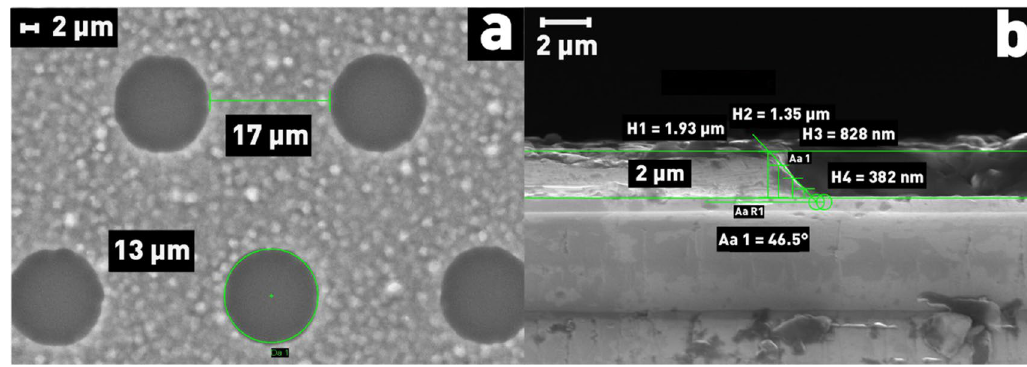
Figure 2. ( a ) Deposited mask (top view); ( b ) sideview of the windows in deposited Al